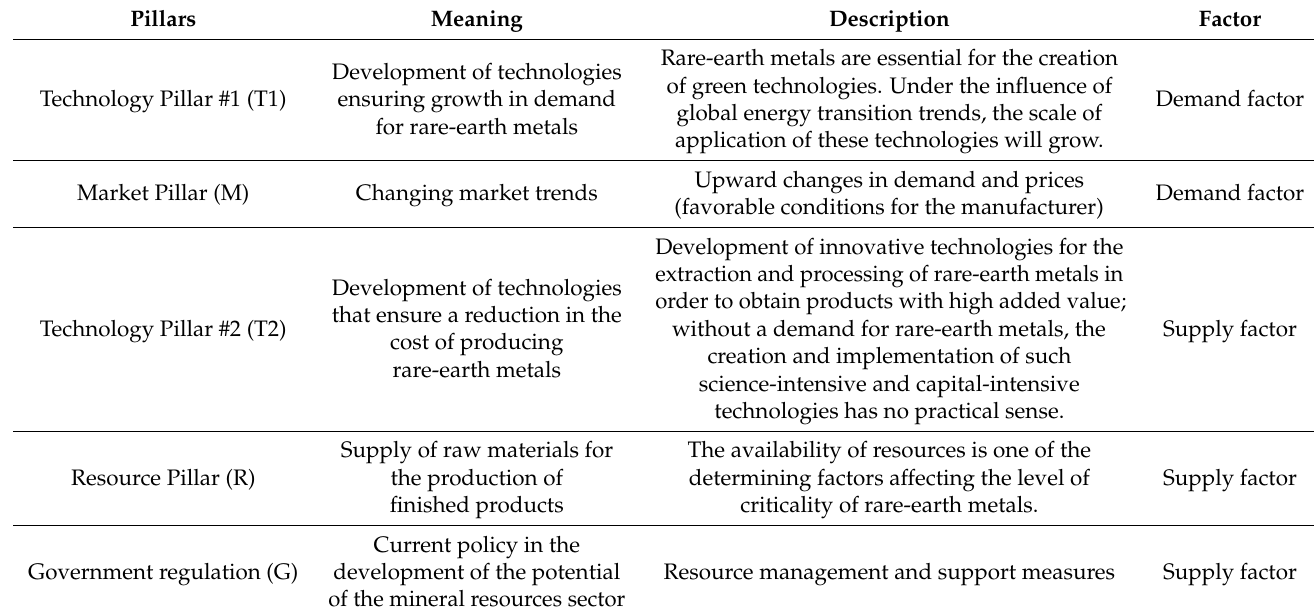
Table 2. Description of the pillars shown (Figure